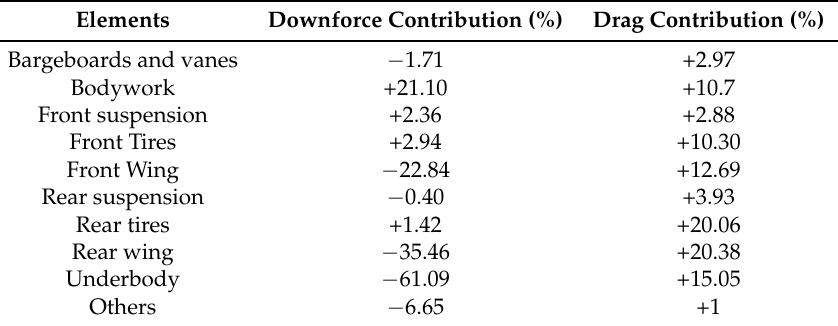
Figure 8. Evaluated components of a F1. Table 4. Relative downforce and drag contributions of the different